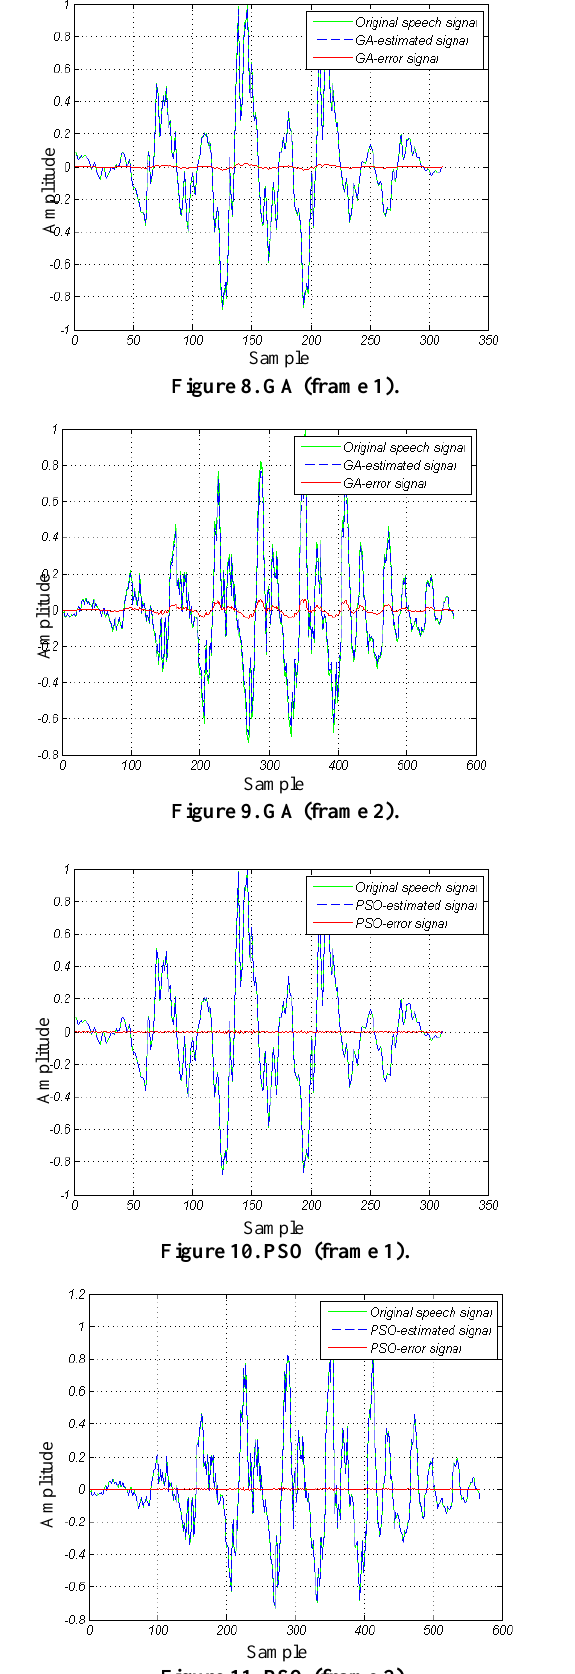
Figure 15. PSO-DV (frame